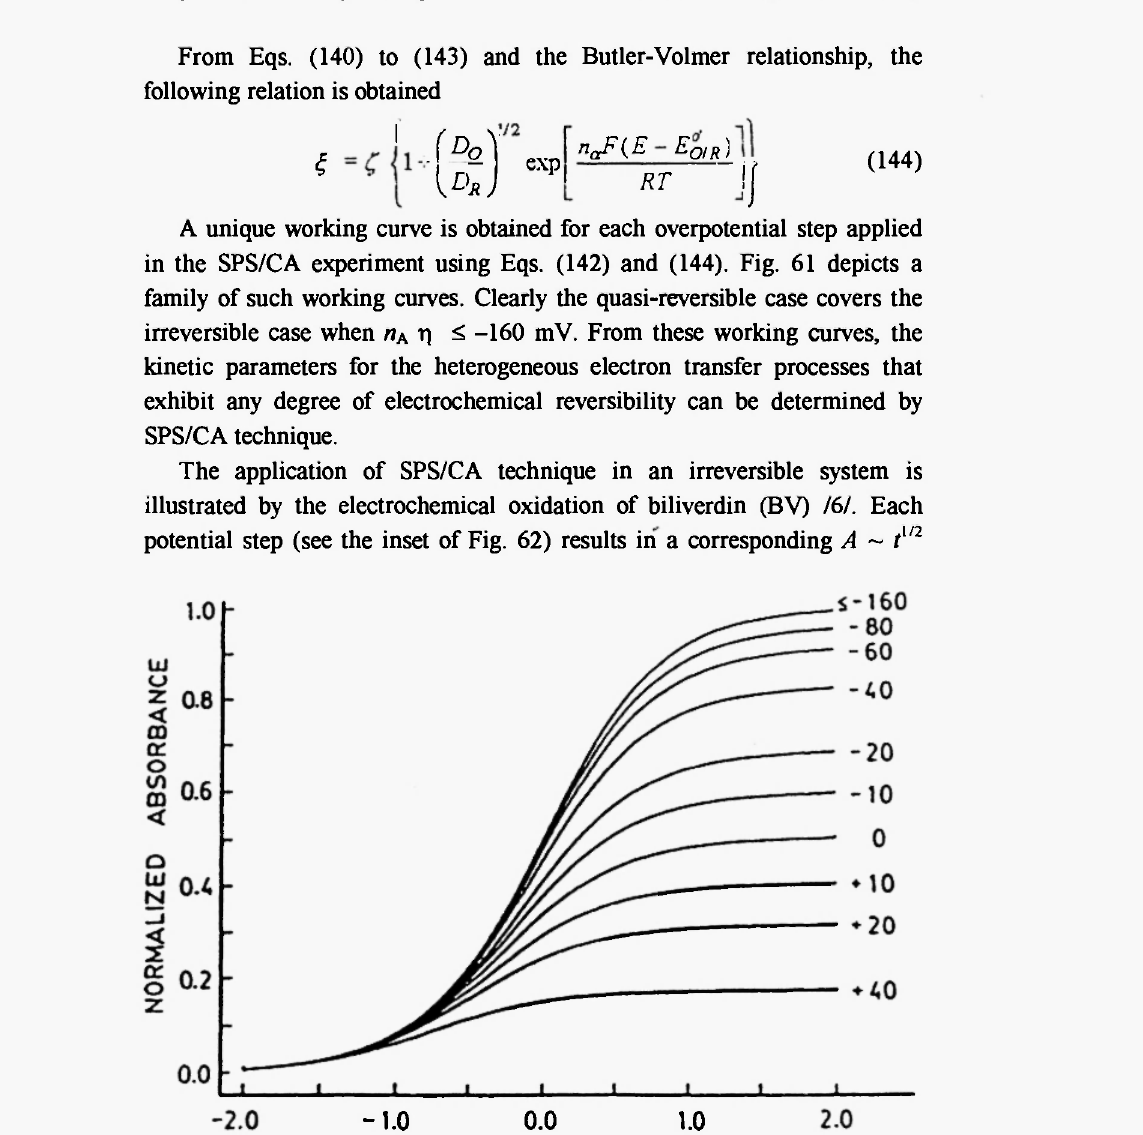
Fig. 61: Working curves for spectroelectrochemical determination of heterogeneous electron transfer rate constants for quasi-reversible reactions. Numerical values correspond to η.η, where η is expressed in mV (From Ref.